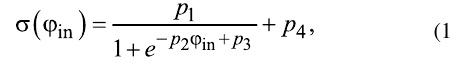
Figure 9: The value of the square of the standard deviation, SD, of the S Q neuron activation function from the mathematical sigmoid (Equa- tion 16) for different inductance l values and rise/fall rates, D , of the input flux φ in ( t ). The horizontal axis is in logarithmic scale. At the initial moment, the system was initialized in the ground state. The parame- ters of the system and the input flux are as follows: A = 4 π , l a = l + 1, l out =